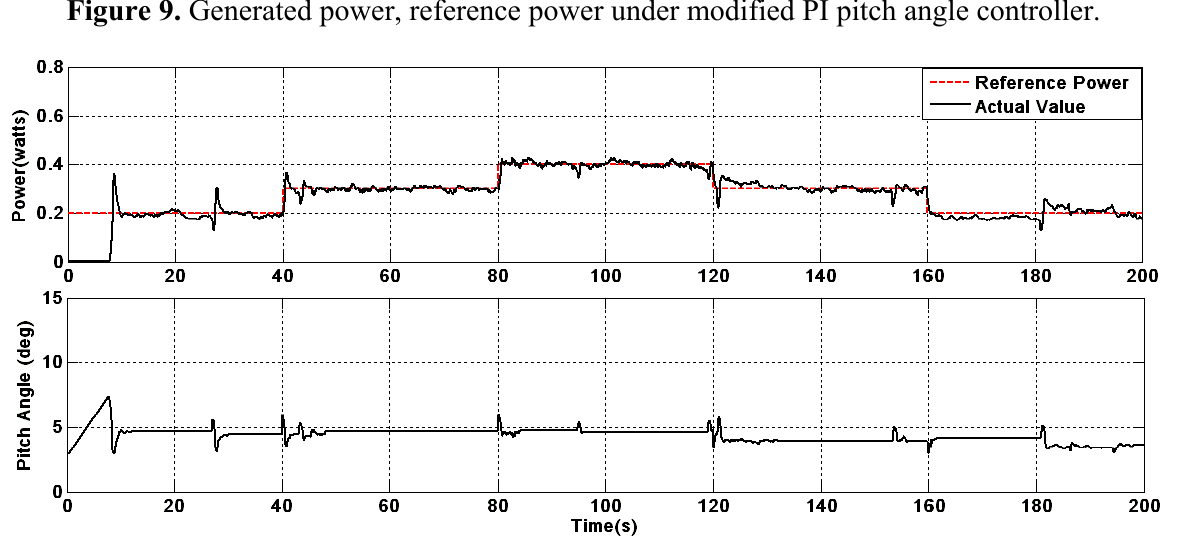
Figure 9. Generated power, reference power under modified PI pitch angle controller.